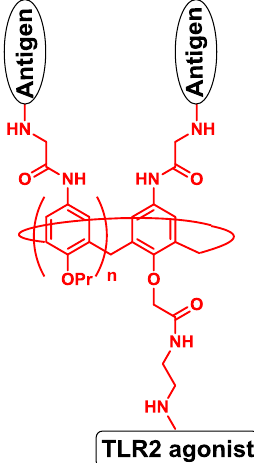
Figure 8. Multivalent template of